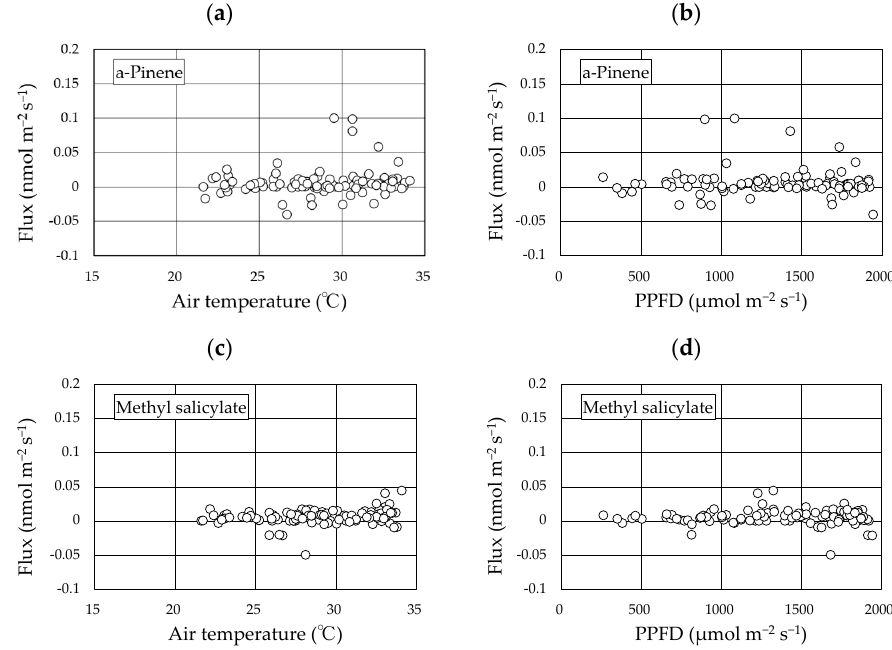
Figure 5. Relationship between the fluxes of two compounds and environmental factors. The data used here include accumulated flux data over two years. ( a ): α -pinene flux vs air temperature; ( b ): α -pinene flux vs. PPFD; ( c ): methyl salicylate flux vs. air temperature; ( d ): methyl salicylate flux vs. PPFD.